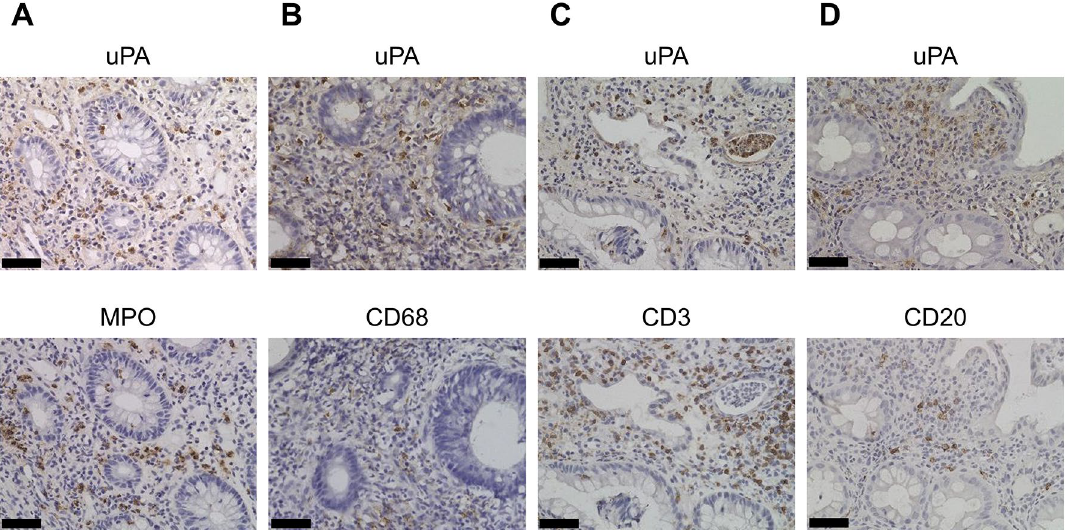
Figure 2. Representative immunohistochemical staining for uPA and MPO, CD68, CD3, or CD20 in inflamed colorectal tissue from UC patients using mirror sections obtained from two serial sections mounted on glass slides with the same cut surface facing upward. One section was stained using anti-uPA antibody and the other with anti-MPO ( A ), anti-CD68 ( B ), anti-CD3 ( C ), or anti-CD20 antibody ( D ). Each section was incubated with primary antibody and subsequently with polymer reagent and visualized by DAB chromogen. Scale bar, 50 μm.